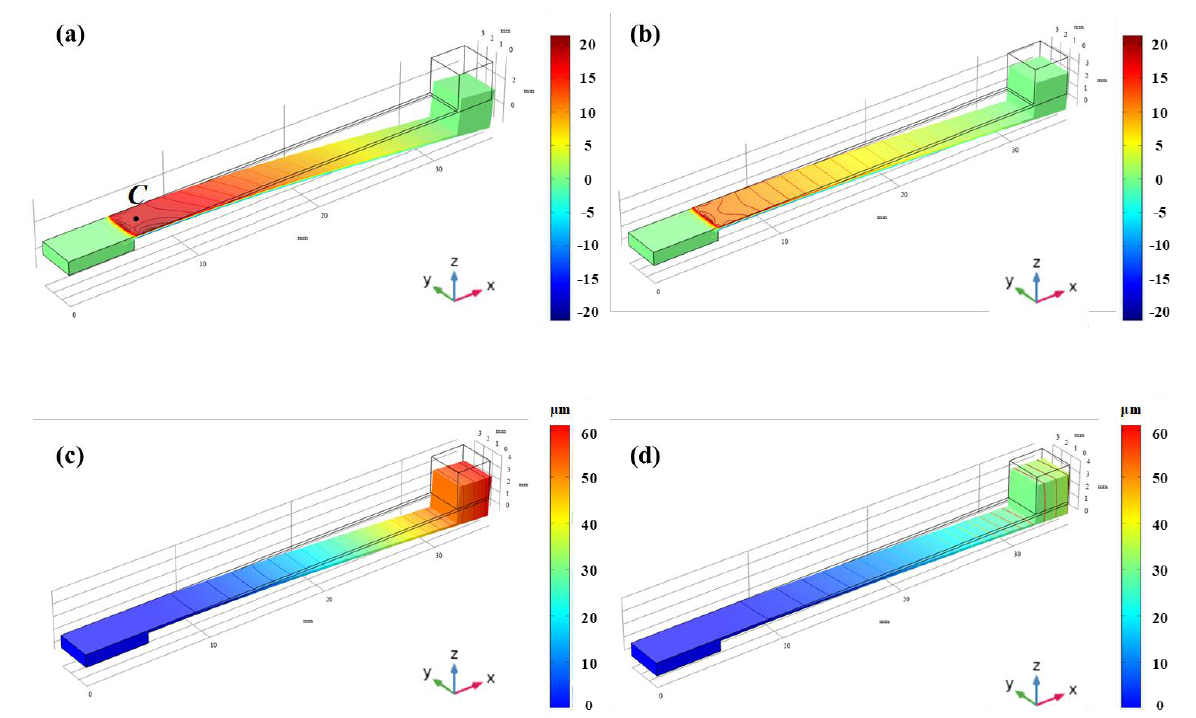
Figure 5. ( a ) Pressure = 1.01 MPa φ = 0° Von Mises Stress; ( b ) Pressure = 1.01 MPa φ = 0° Total Displacement; ( c ) Pressure = 1.01 Mpa φ = 30° Von Mises Stress; ( d ) Pressure = 1.01 MPa φ = 30° Total Displacement.